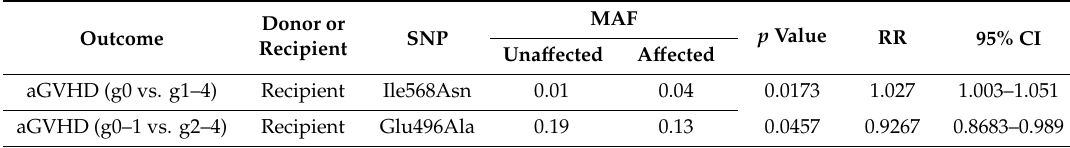
Table 3. Summary of significant SNP